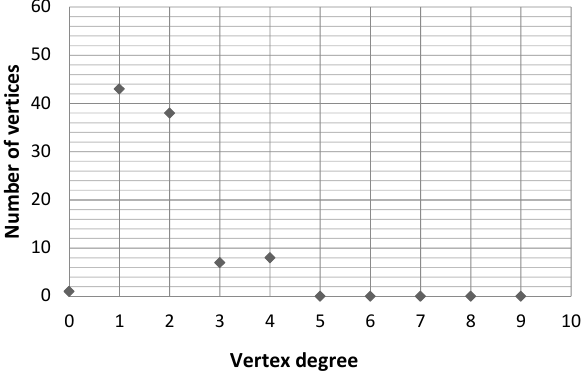
Figure 14. Vertex degree distribution after removing five vertices (STW, BGC, RZE, CHM, PEL).